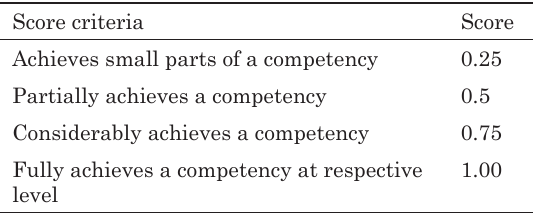
Table 1. Map scoring